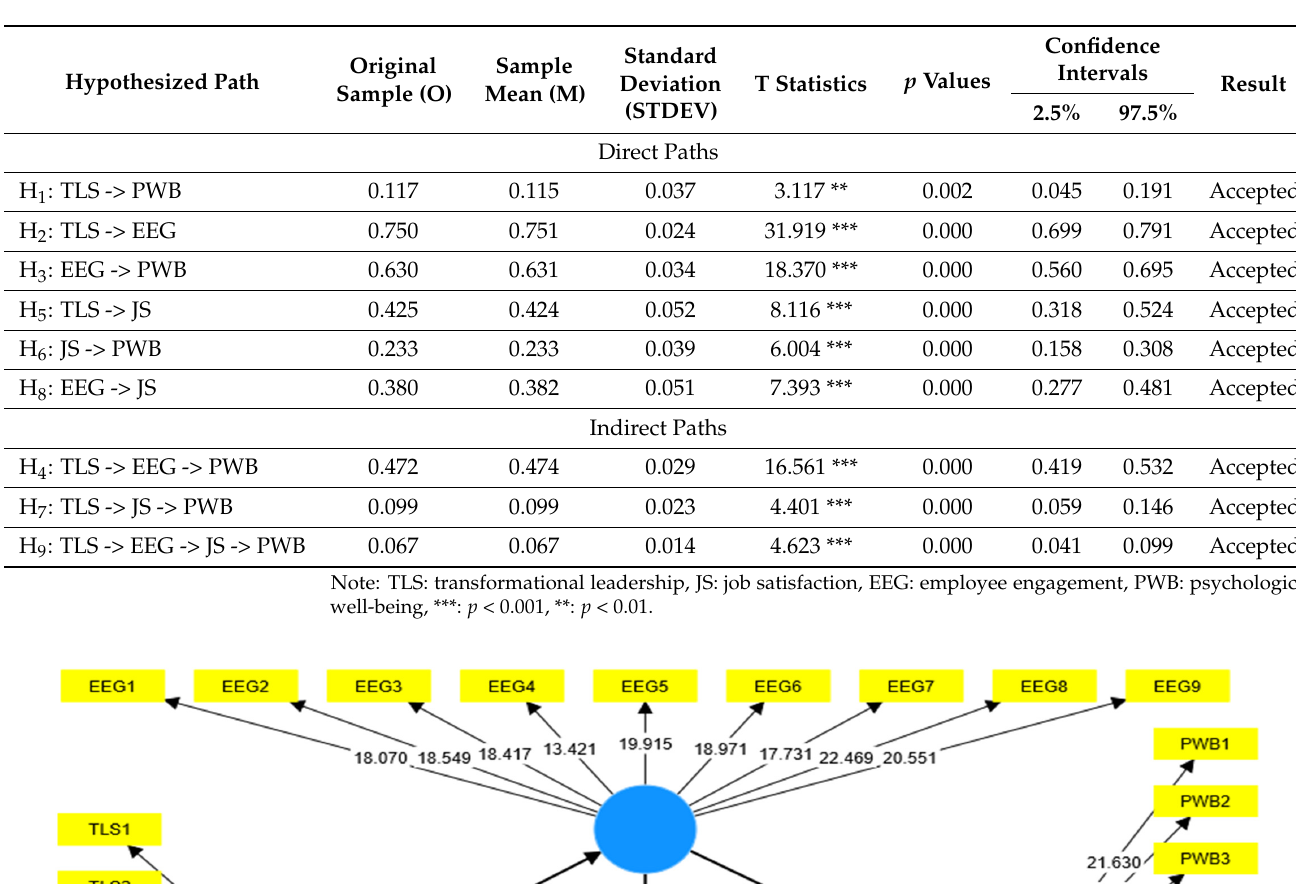
Table 6. Structural Parameter Estimates.